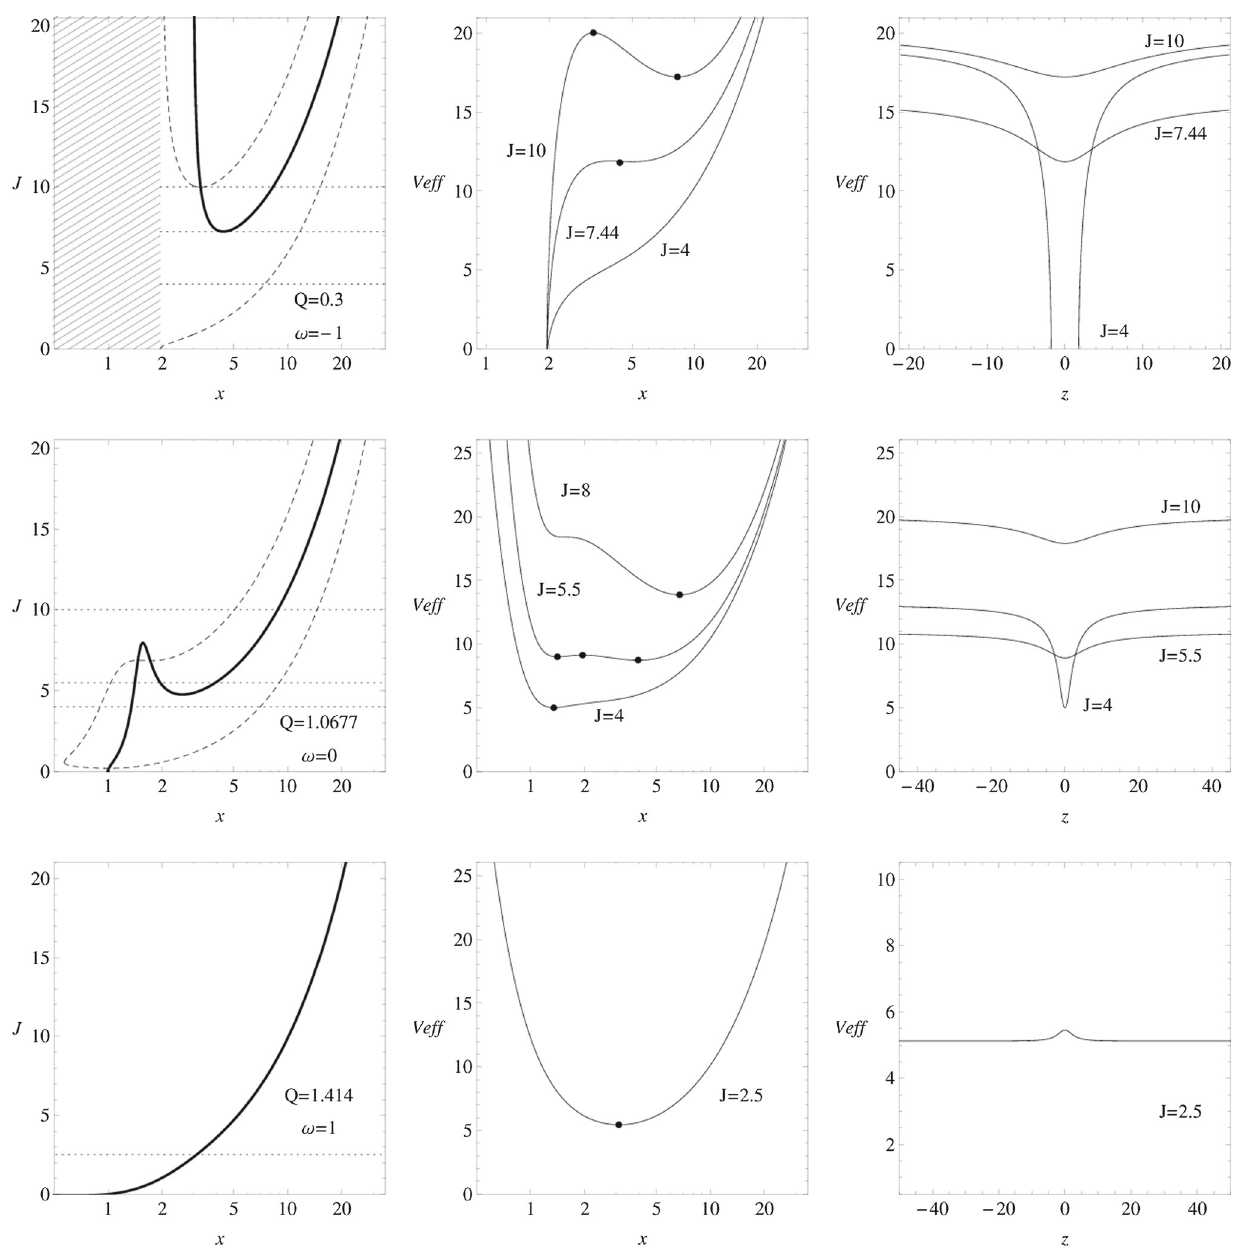
Fig. 5 The behavior of J ext function and boundary angular momentum parameter functions J L1 , J L2 and the corresponding effective potentials. Dots denote the extreme points of effective potential V eff . Shaded region stands for area below black hole